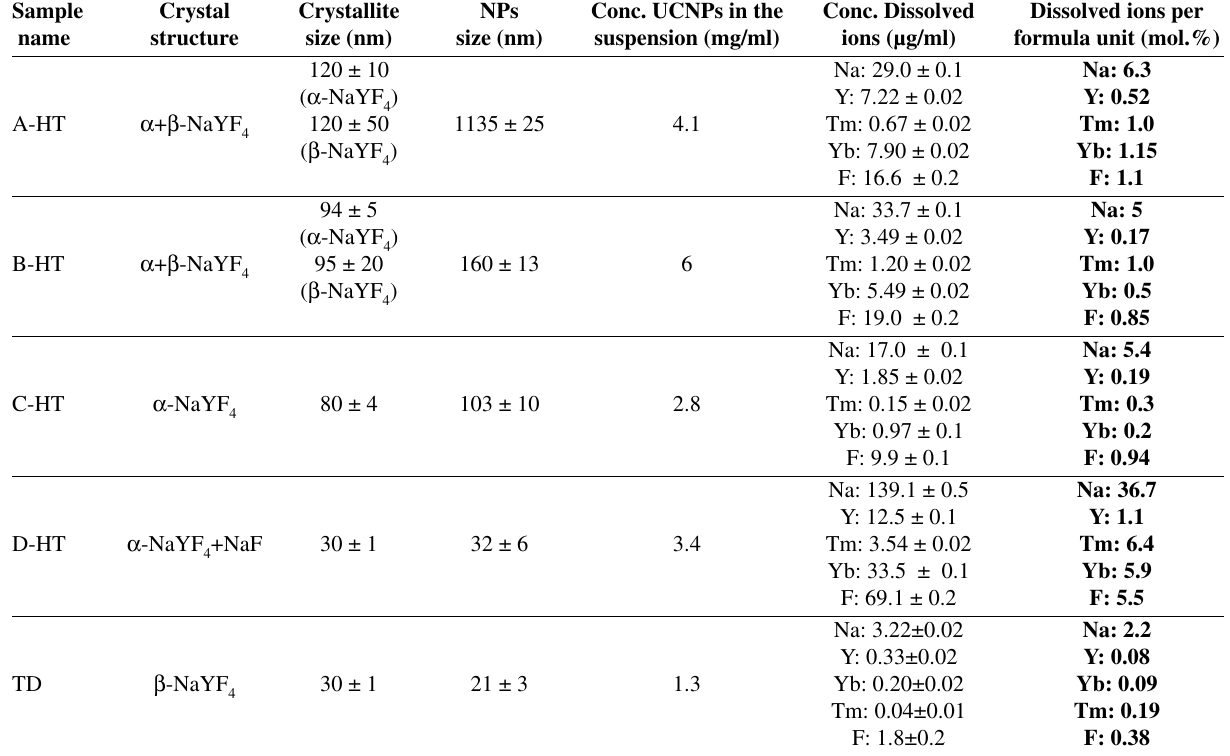
Table 2: Basic properties and the dissolution data of the synthesized UCNPs. Sample Crystal Crystallite NPs Conc. UCNPs in the Conc. Dissolved